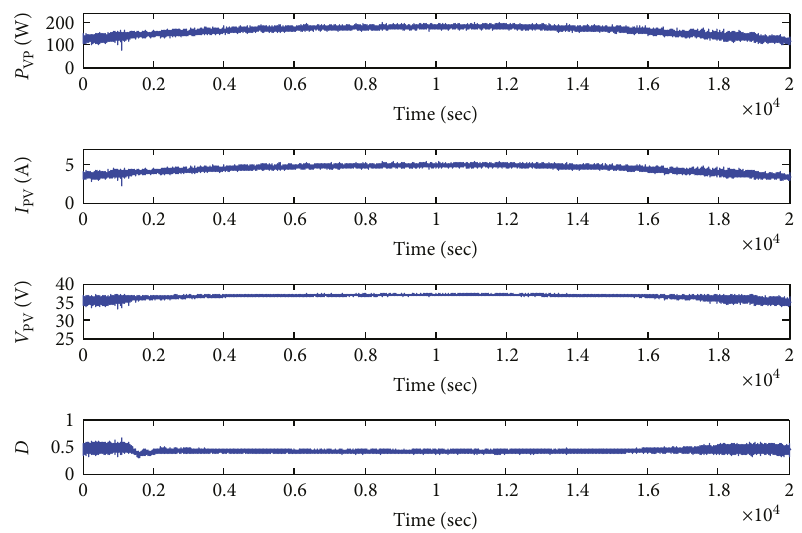
Figure 21: Experimentally tracking behavior of the ANFIS MPPT. From 9:23AM to